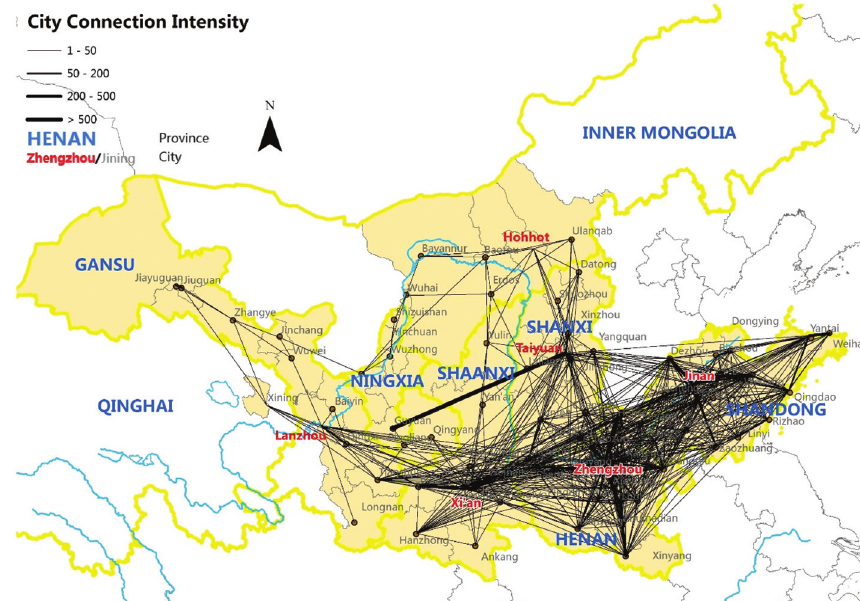
Figure 3: Distribution map of the maximum value of city connection intensity in the Yellow River basin.